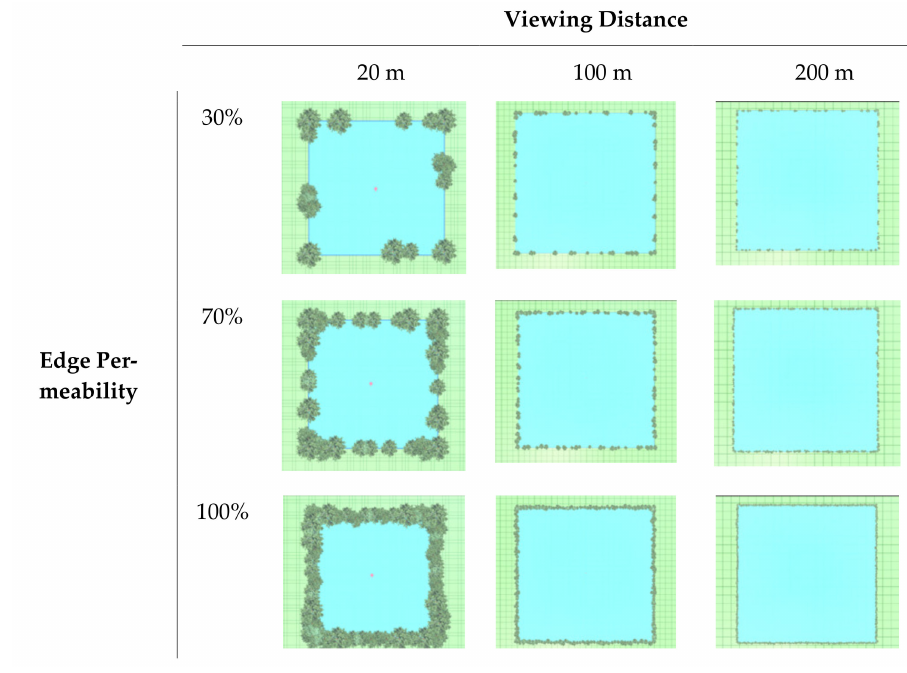
Figure 2. VR landscape scene design plans.